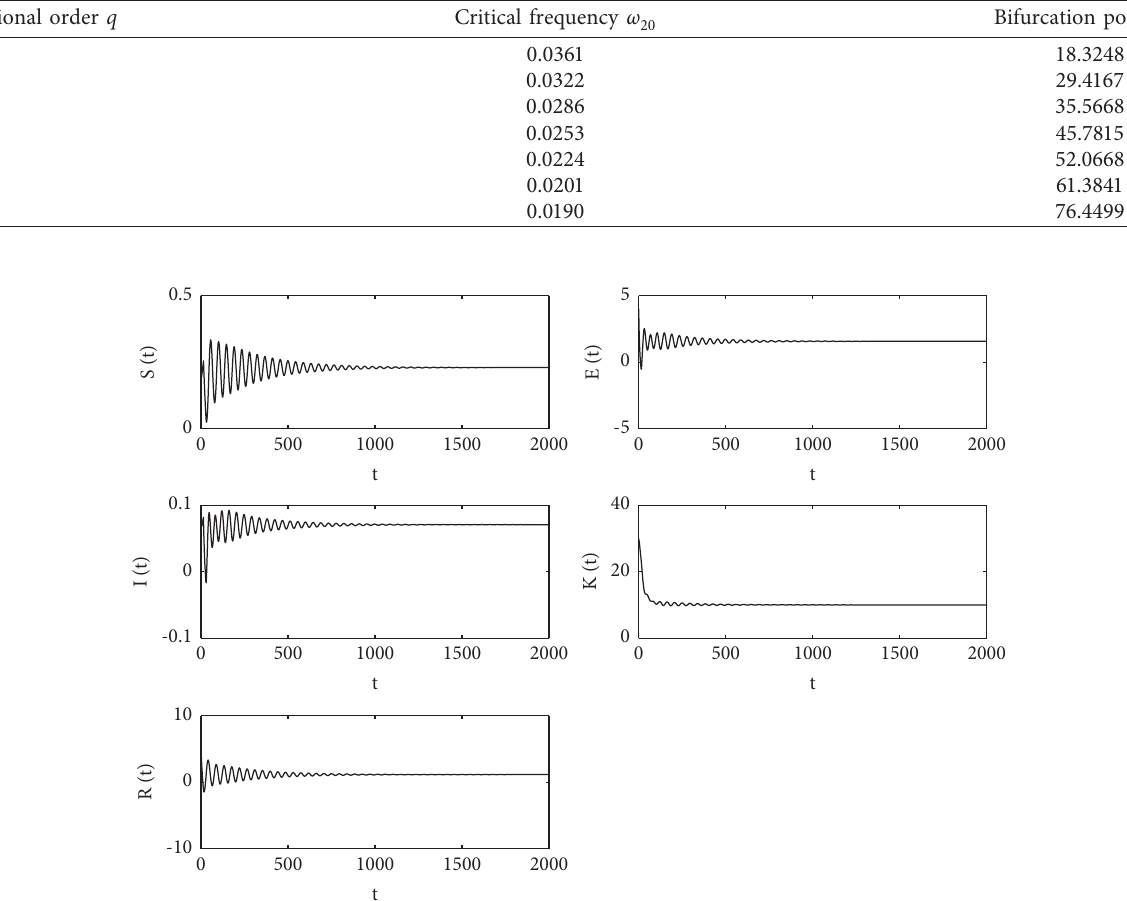
Figure 5: State trajectories of fractional system (4). When τ asymptotically stable.